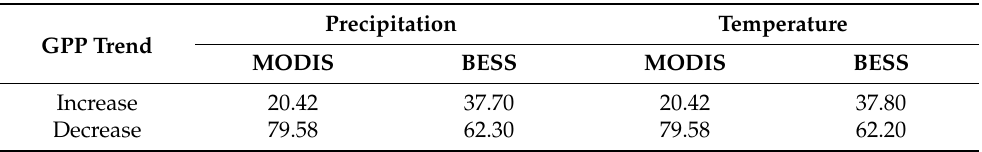
Figure 12. Area percentage of GPP significantly correlated ( p < 0.05) to precipitation and temperature in restoration areas. Table 3. Area percentages of increasing and decreasing GPPs significantly correlated ( p < 0.05) to precipitation and temperature in restoration areas.